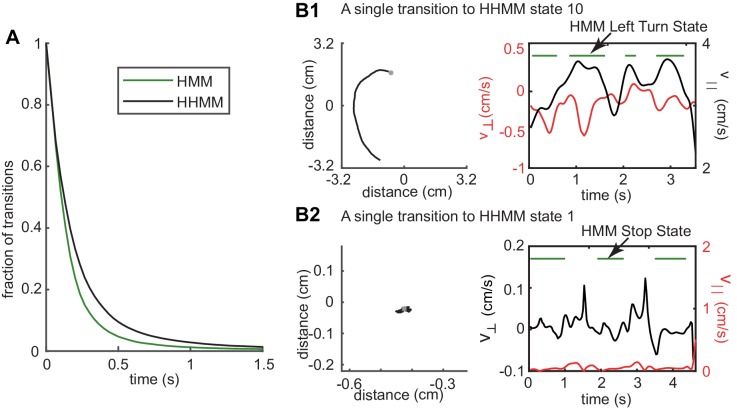
Longer duration of HHMM states allows it to discover structure in the data over longer times.(A) Complementary cumulative distribution (cCDF) of tracks for HHMM vs. HMM states showing that HHMM states have many more tracks with longer durations. (B1) An example track that represents a single HHMM state. HMM detects this track as a left turn but its assignment of the track as a left turn (green lines) is intermittent. (B2) Another example - in this case for a stop state. In both examples, changes in the value of the observables result in the intermittency of the HMM state. The observable resulting in the intermittency is colored red. In the case of B1, small straight segments within the left turn result in the intermittency. In the case of B2, small movements cause an exit from the stop state.